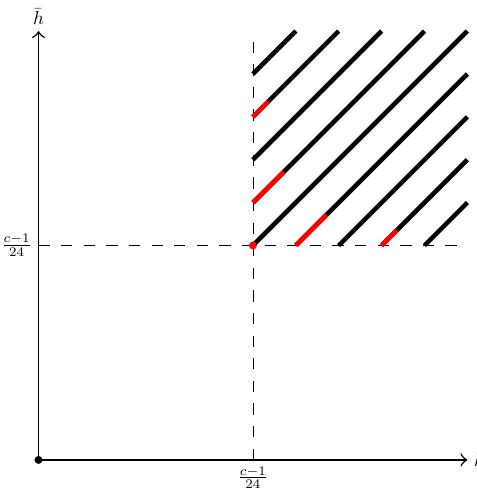
Figure 1. The spectrum of the MWK partition function. We start with the vacuum state, at h = (cid:22) h = 0 and get a continuous spectra at all integer spins, with h; (cid:22) h (cid:21) c (cid:0) 1 unitarity; the red regions represent the parts of the spectrum where the density of states is